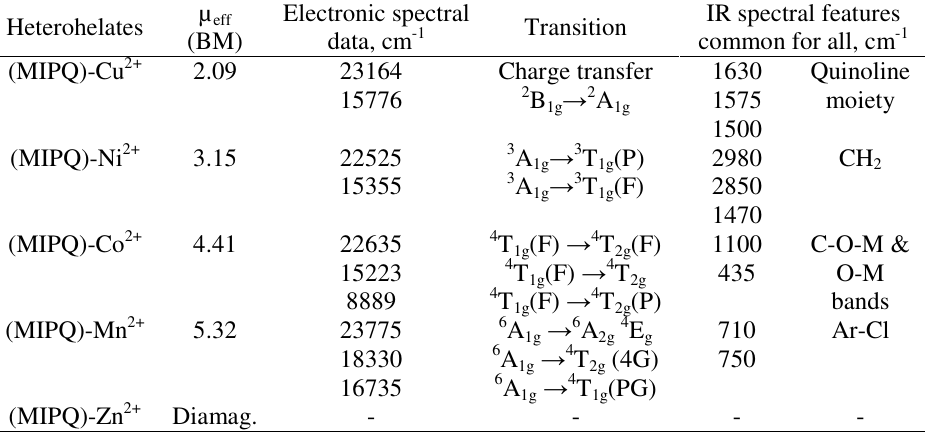
Table 2 . Spectral features and magnetic moment of MIPQ ligand and it’s heterochelates µ Electronic spectral eff Heterohelates (BM) data, cm -1